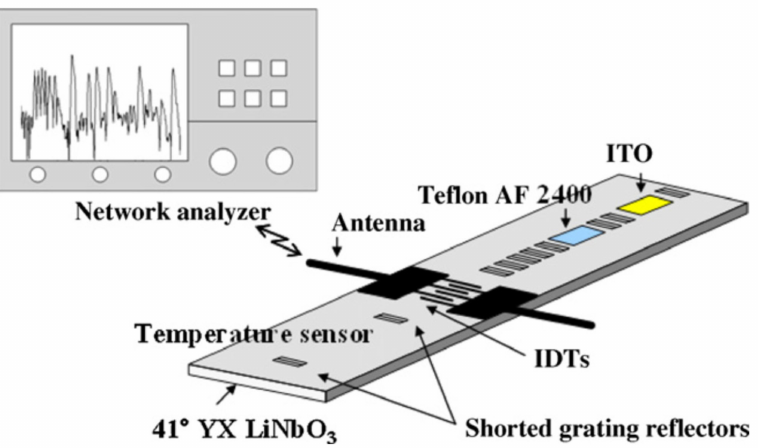
Figure 8. Schematic view of wireless chemical sensor system. Reprinted with permission from Ref. [74]. Copyright 2011 Elsevier.